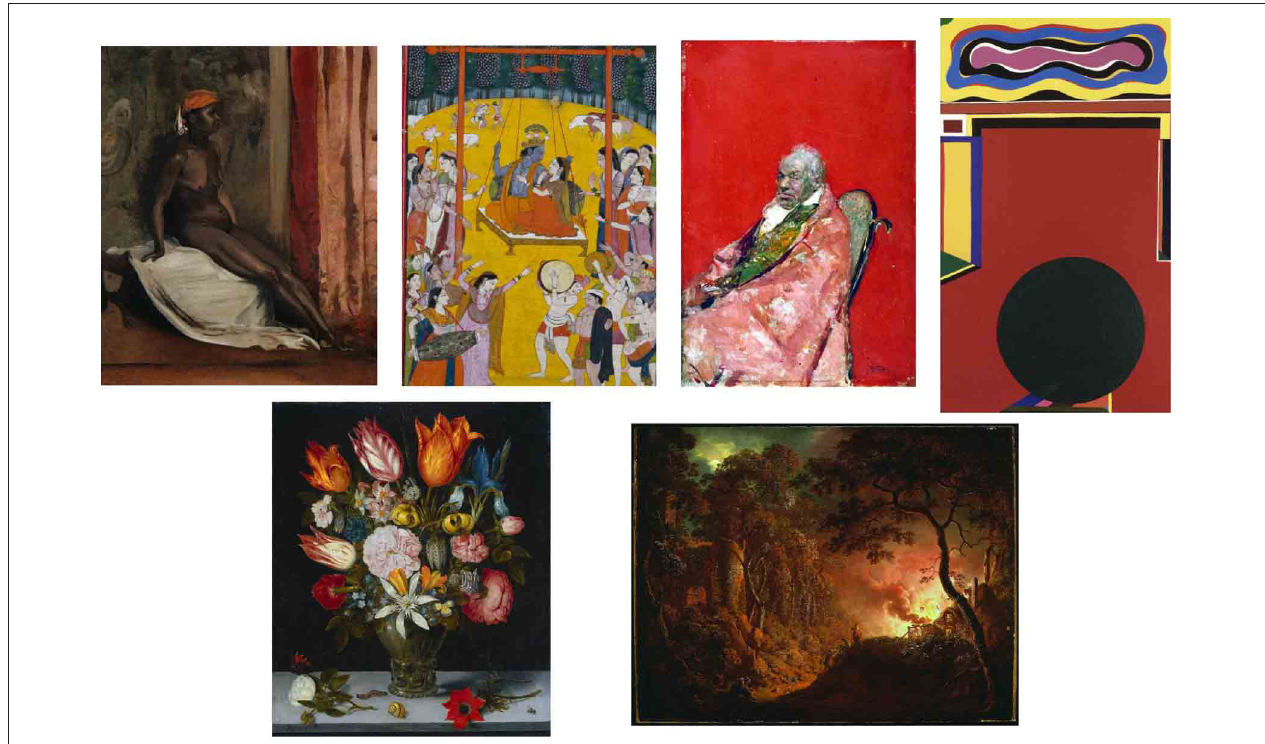
FIGURE 1 | Examples of the artworks used in this experiment. All images were obtained from the Catalog of Art Museum Images Online (CAMIO) database (http://www.oclc.org/camio). See List of artworks for image credits and the full list of artworks used in the experiment.